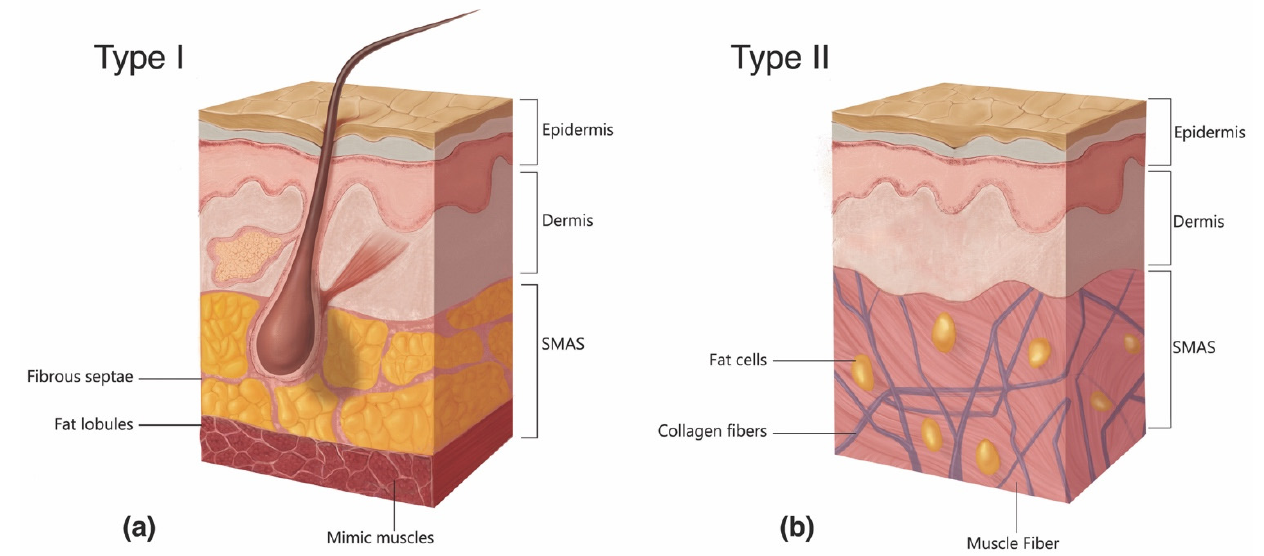
Figure 8. The two types of histomorphology of the facial superficial musculoaponeurotic system (SMAS). ( a ) Type I morphology is found predominantly in the cheek, forehead, and lateral face and features a uniform layer of adipose tissue interspersed amidst the fibrous septa spanning the space between the SMAS and the dermis. ( b ) Type II morphology is present in the central facial tissues of the perioral and perinasal regions and is characterized by thick fibromuscular insertions emanating from the SMAS directly into the dermis, forming a more rigid adhesion between the two planes.